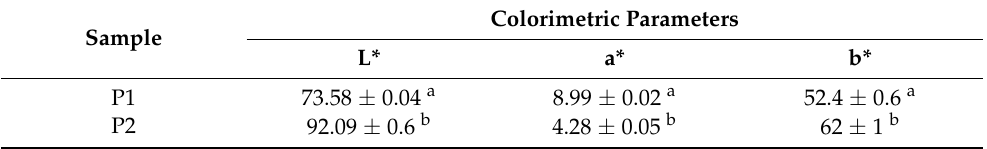
Table 2. Colorimetric parameters of microencapsulated sea buckthorn extract. Sample